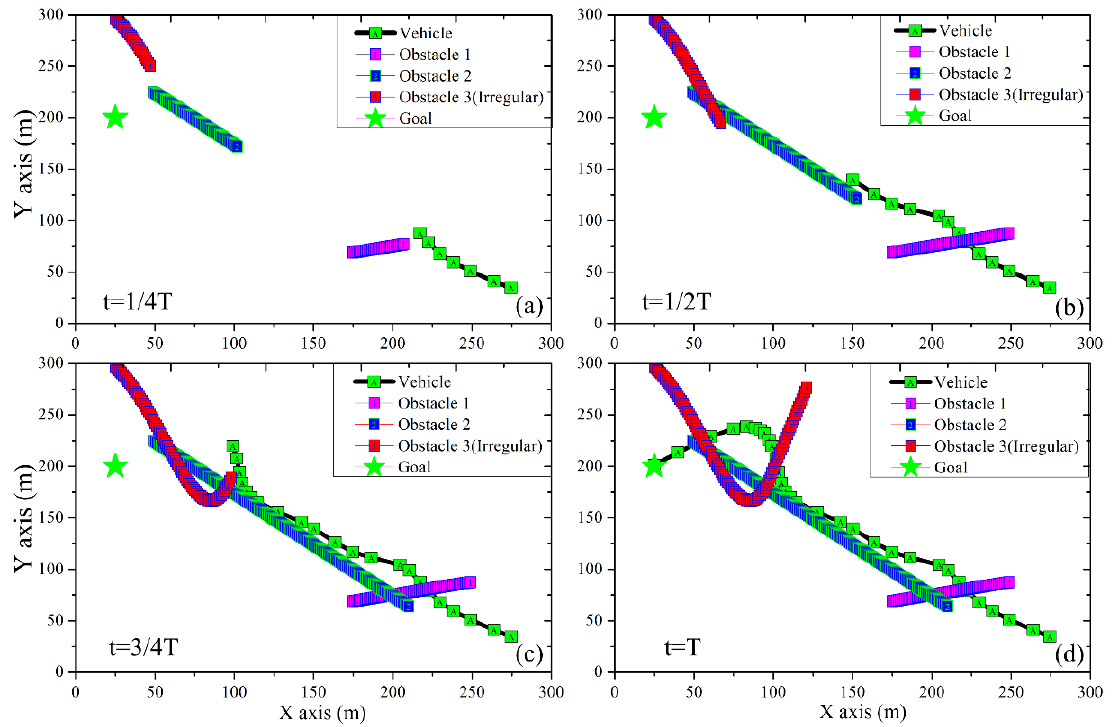
Figure 4. The planning results in dynamic environment: ( a ) at 1/4 of the total time, ( b ) at half of the total time, ( c ) at 3/4 of the total time, ( d ) at the end of the planned period.